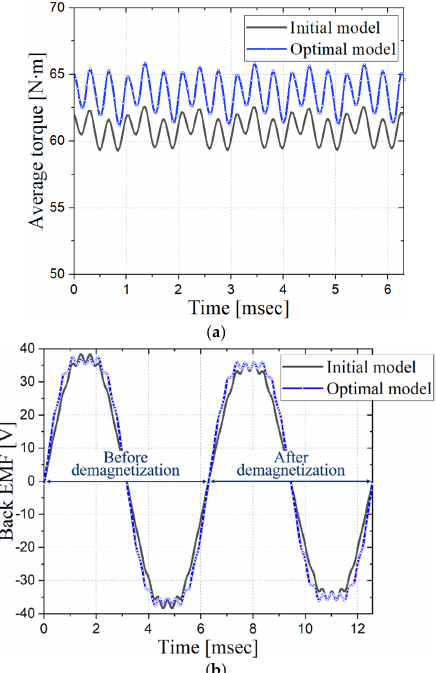
Figure 10. Torque and back EMF waveforms: ( a ) torque; ( b ) back EMF.